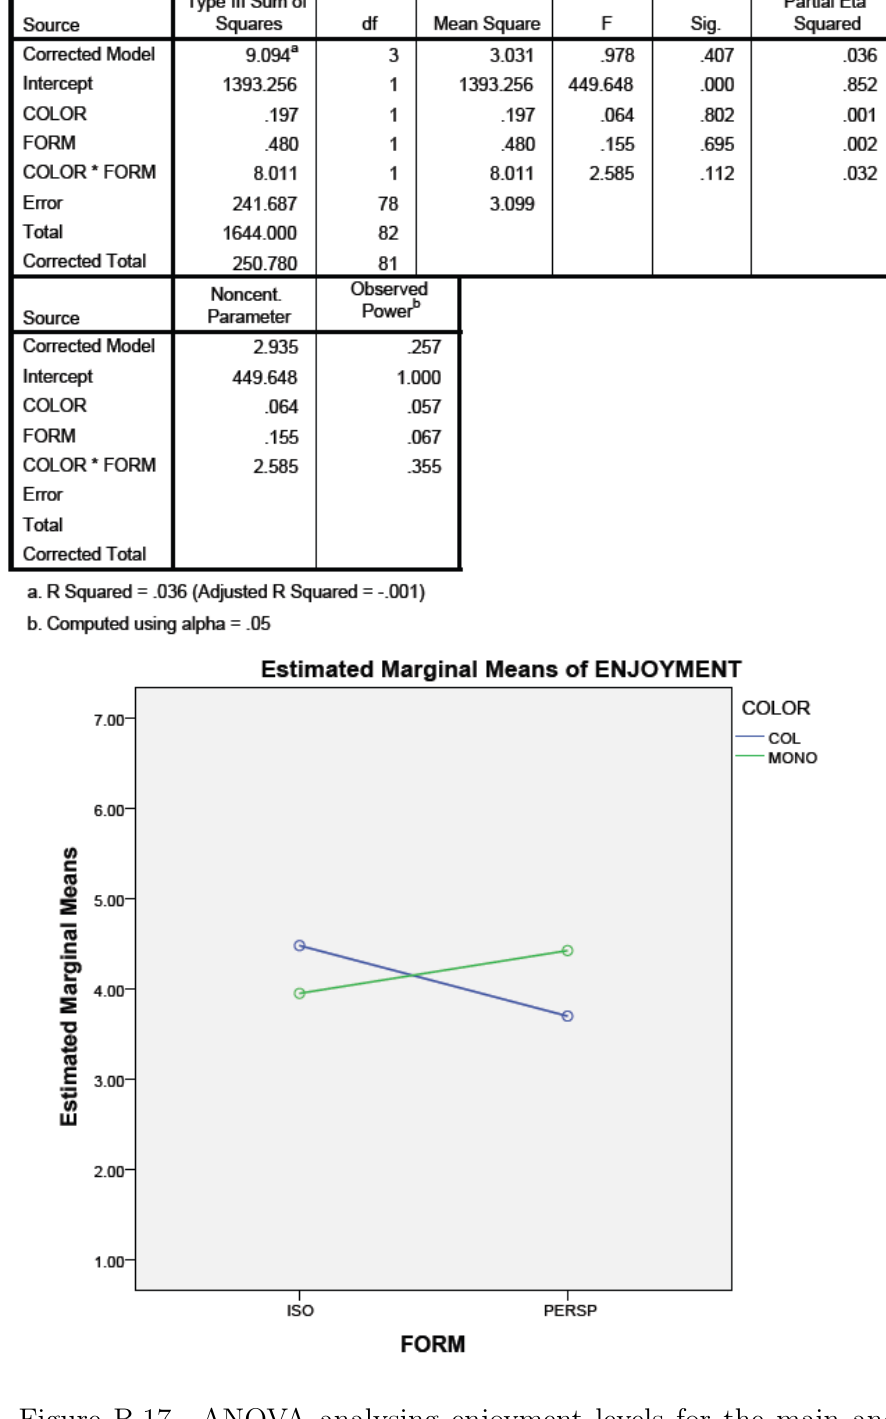
Figure B.17. ANOVA analysing enjoyment levels for the main and interaction effects of color and form using raw